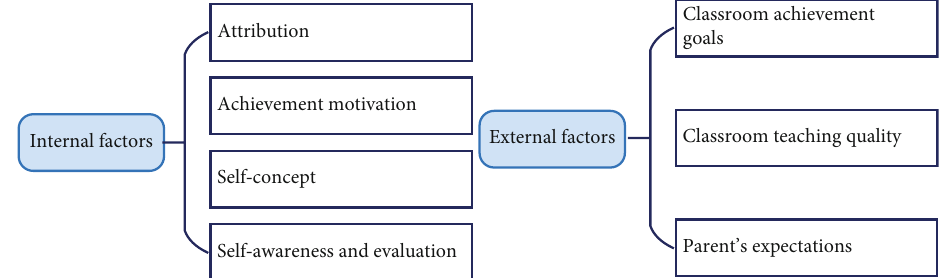
Figure 3: The speci fi c performance of both internal and external